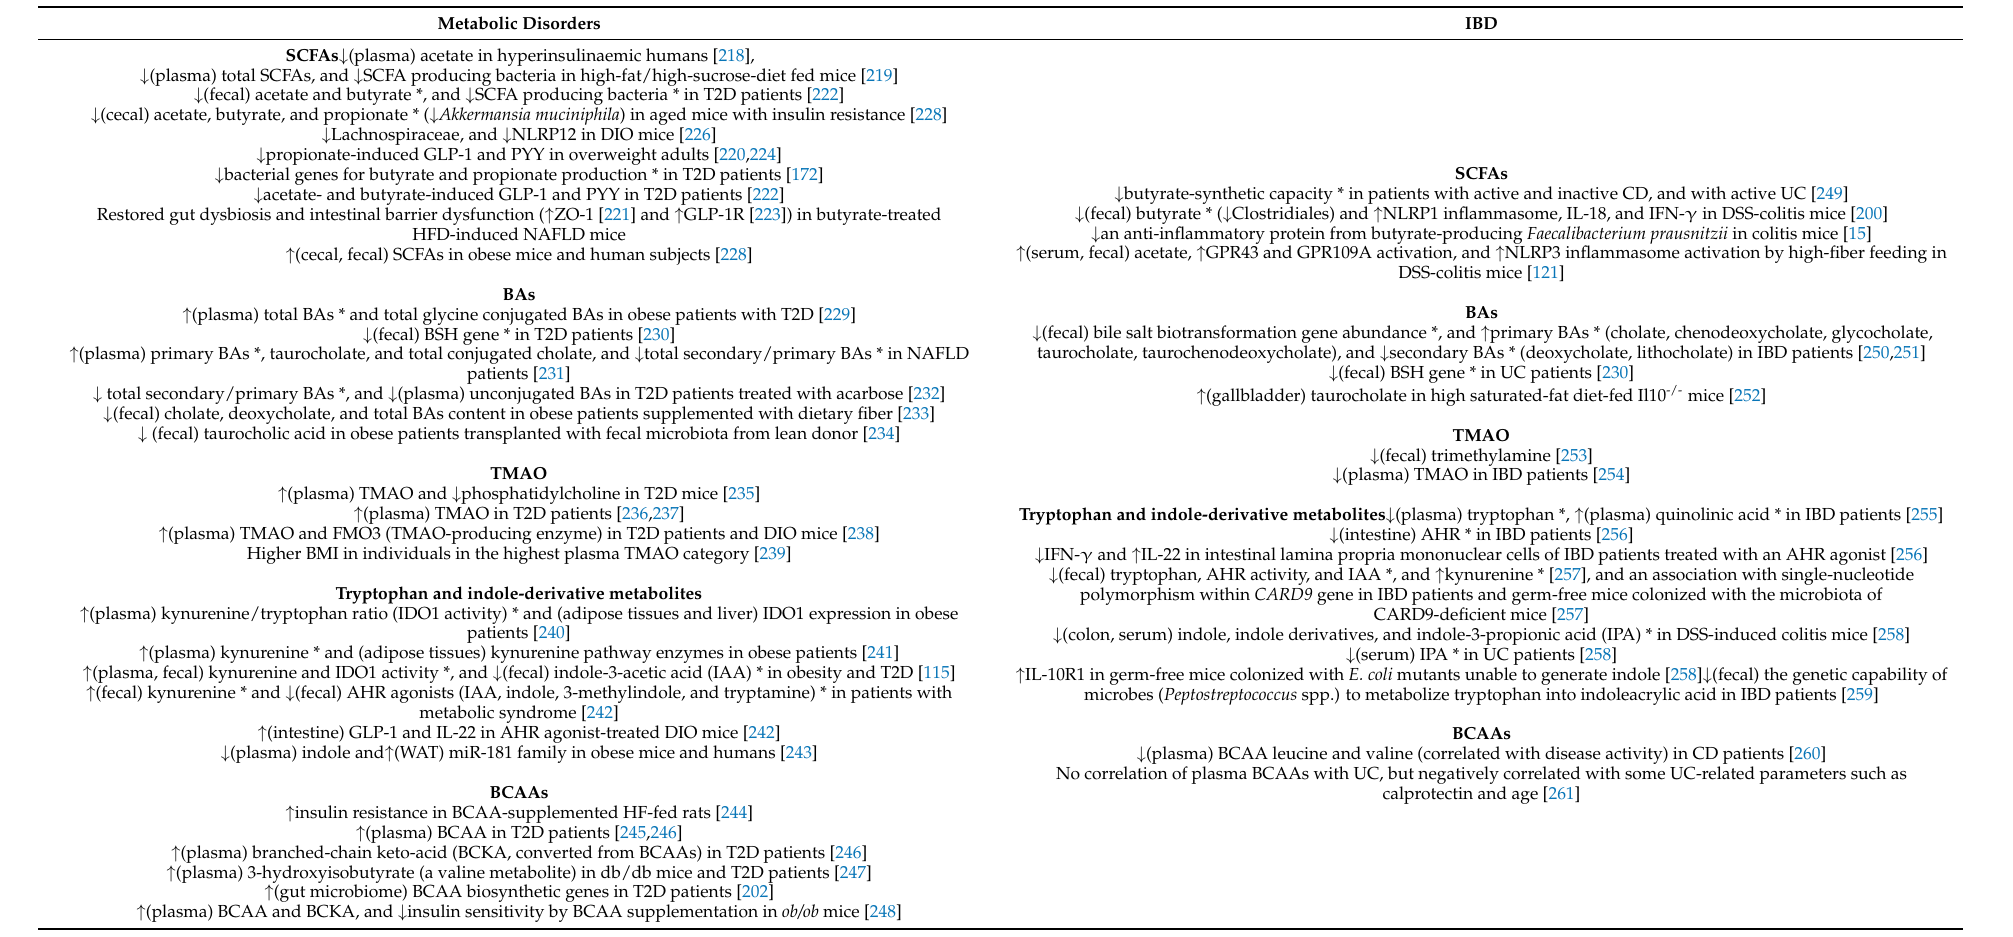
Table 3. Alterations in gut microbiota-derived metabolites in metabolic disorders and